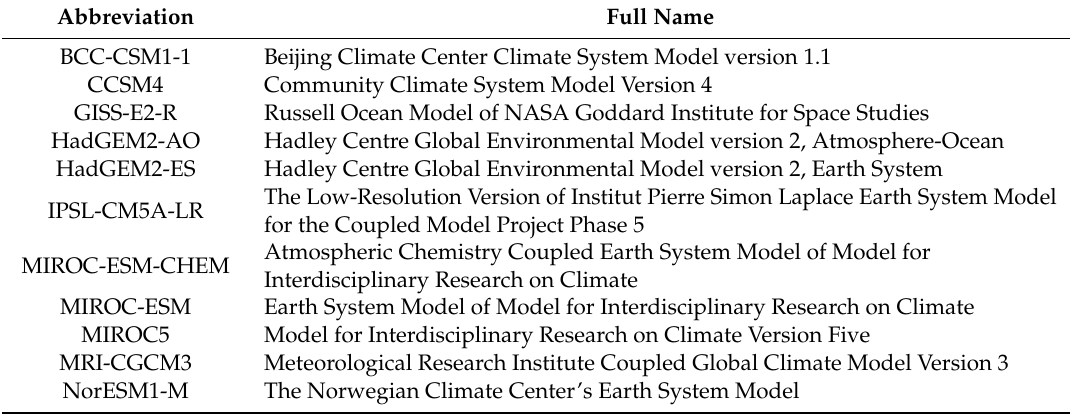
Table 2. Summary of global climate models used in this